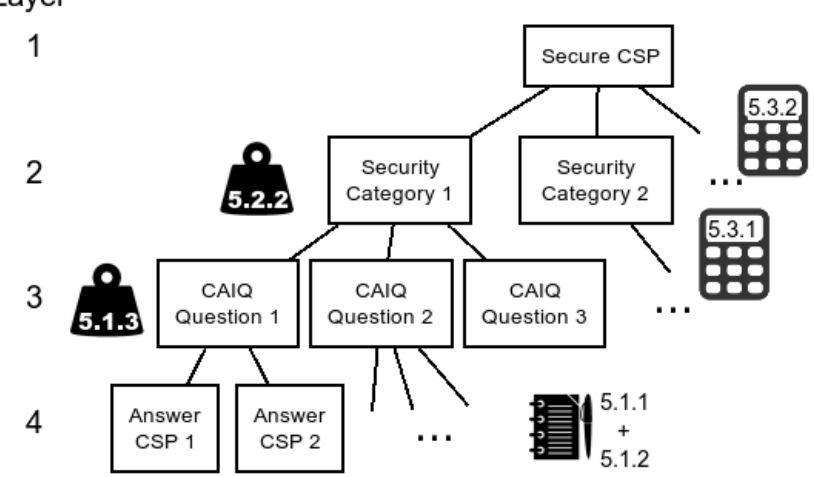
Figure 7. Hierarchies of Analytic Hierarchy Process (AHP) based